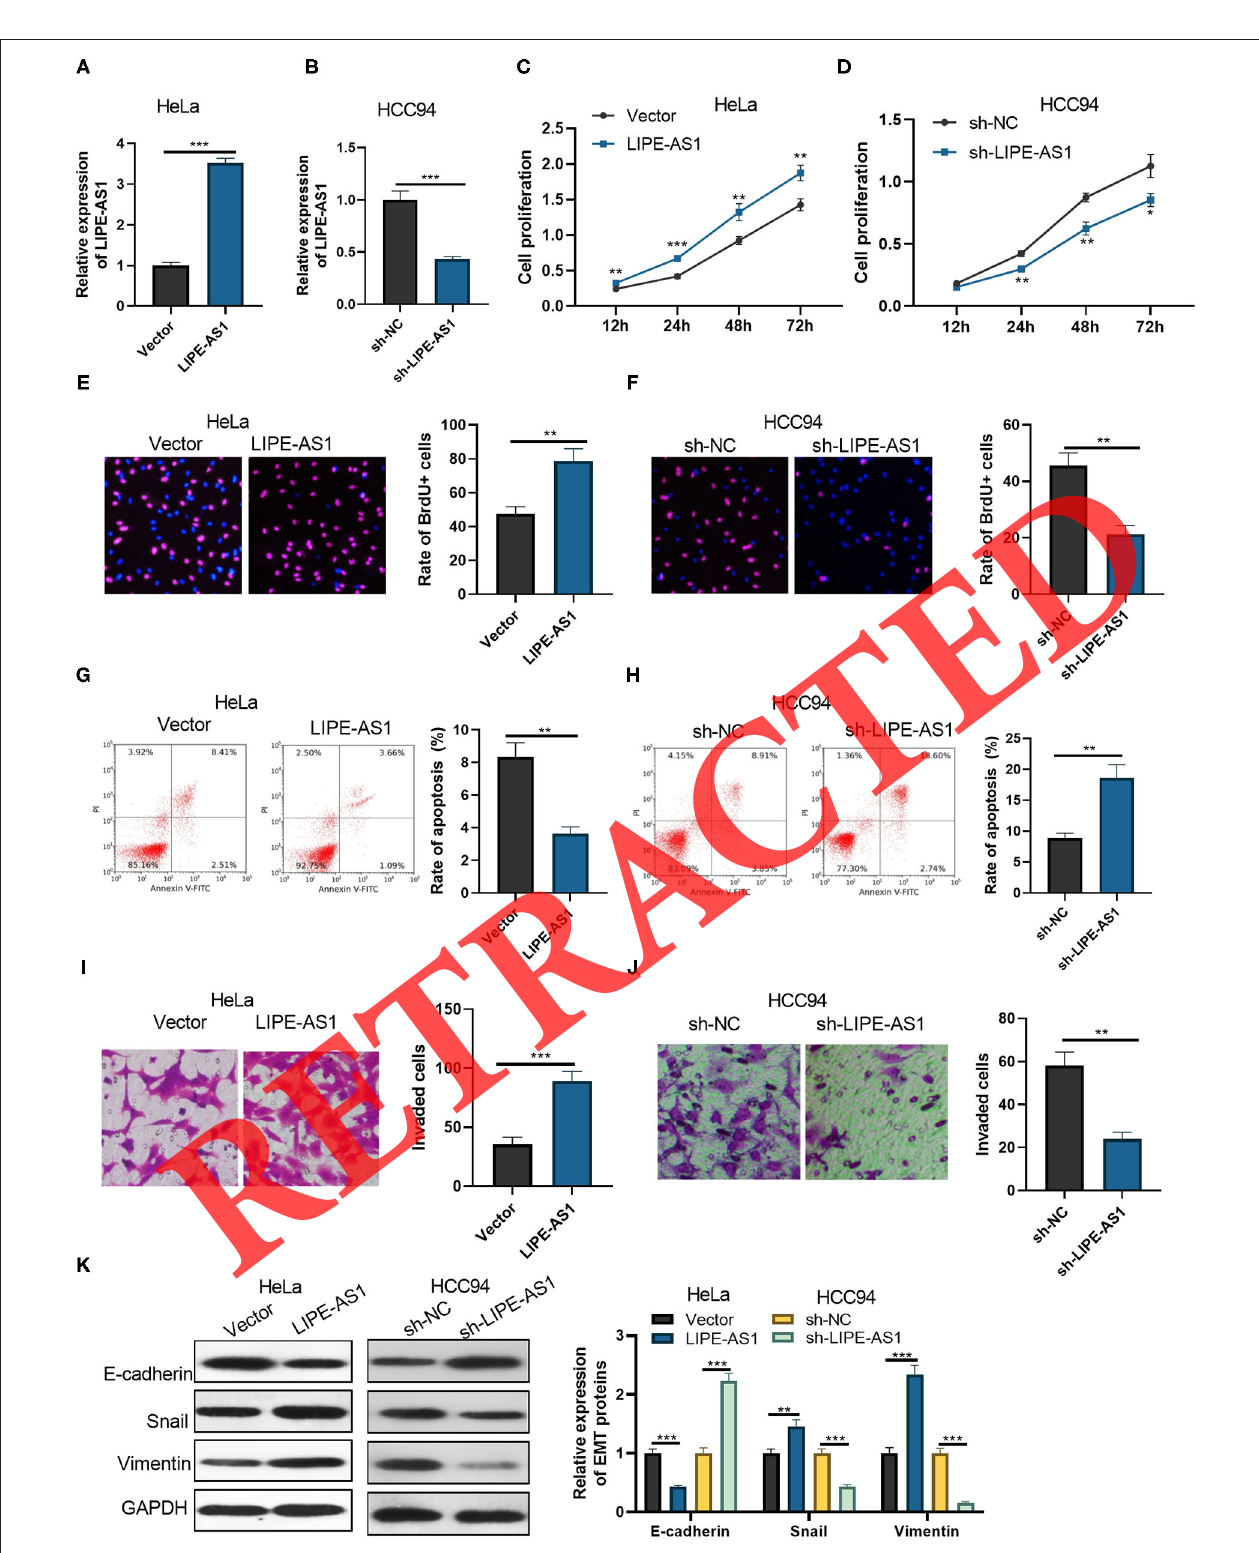
FIGURE 2 | LIPE-AS1 promotes cervical cancer cell proliferation, invasion, and EMT. LIPE-AS1 over- and low-expressing cell models were constructed in HeLa (A) and HCC94 cells (B) , respectively. CCK8 was applied to examine the proliferation of HeLa (C) and HCC94 cells (D) . * P < 0.05, ** P < 0.01 vs. Vector group or sh-NC group. BrdU method was taken to examine the proliferation of HeLa (E) and HCC94 cells (F) . Flow cytometry was performed to test the apoptosis of HeLa (G) and HCC94 cells (H) . Transwell method was performed to evaluate the invasion of HeLa (I) and HCC94 cells (J) . (K) The expressions of E-cadherin, Snail and Vimentin in HeLa and HCC94 cells were detected by Western blot. * P < 0.05, ** P < 0.01, *** P < 0.001. N = 3.